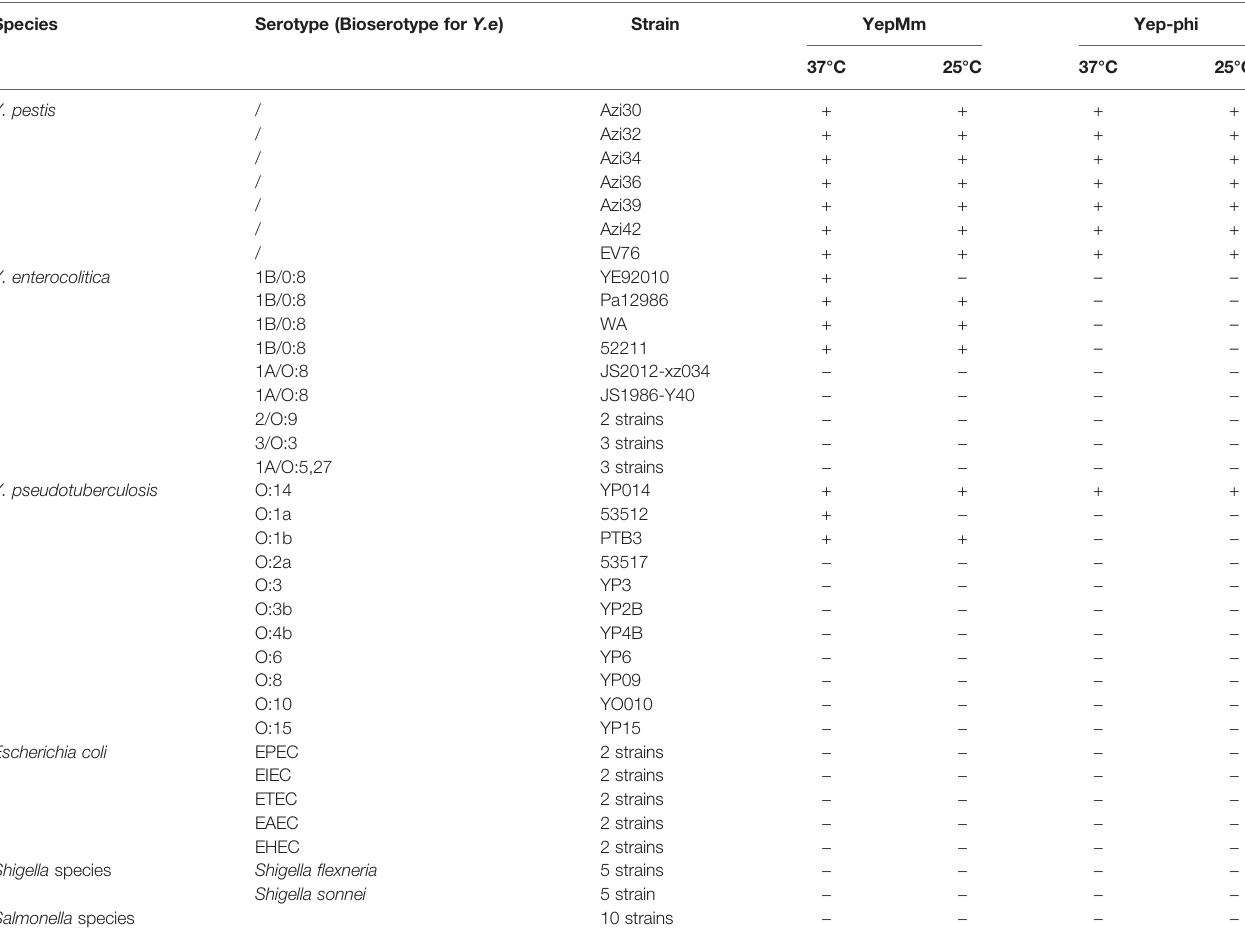
TABLE 1 | Lytic activity of the bacteriophages Yep-phi and YepMm at 37°C and 25°C.